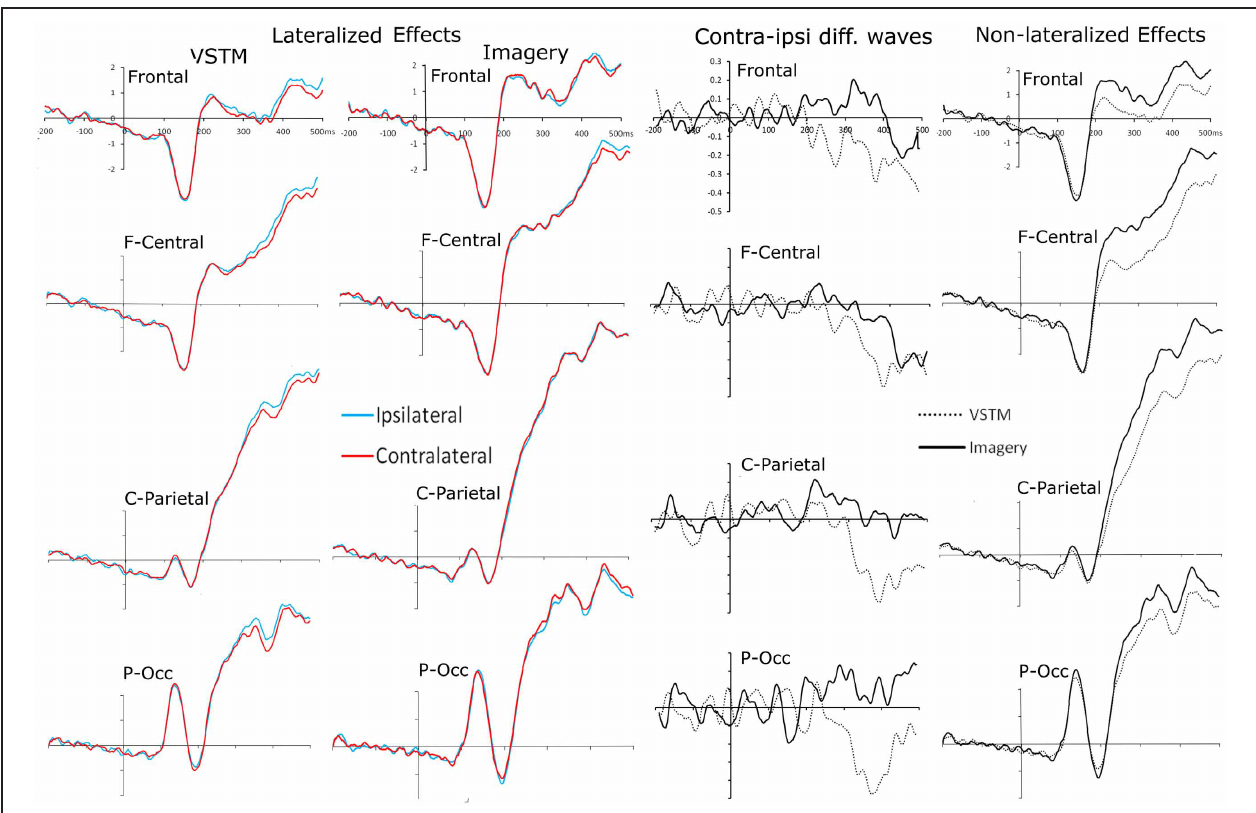
imagined location of the centrally presented probe shape. The middle-right hand column shows the contralateral minus ipsilateral difference waves for each condition at each electrode cluster. The far right column shows a comparison of waveforms from the VSTM- and Imagery-search conditions, collapsed across the relative contralaterality of the recording.